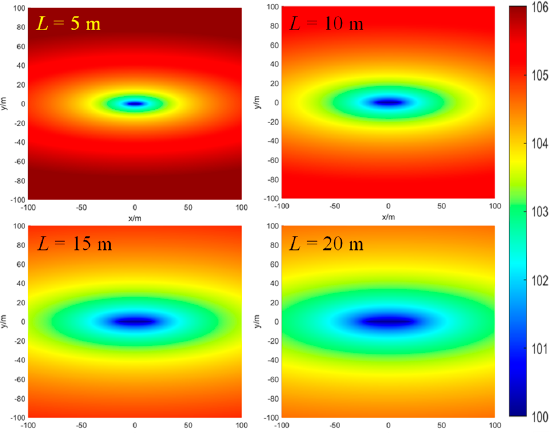
Figure 1. Pressure field distribution of a single borehole coal seam in homogeneous state: ( a ) Unfractured coal seam, ( b ) Coal seam fracturing.